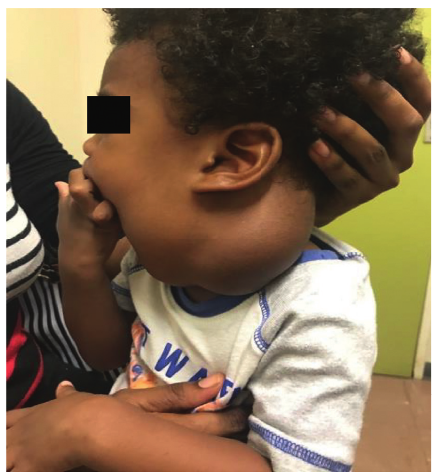
Figure 6: Cystic hygroma 1 month after treatment.